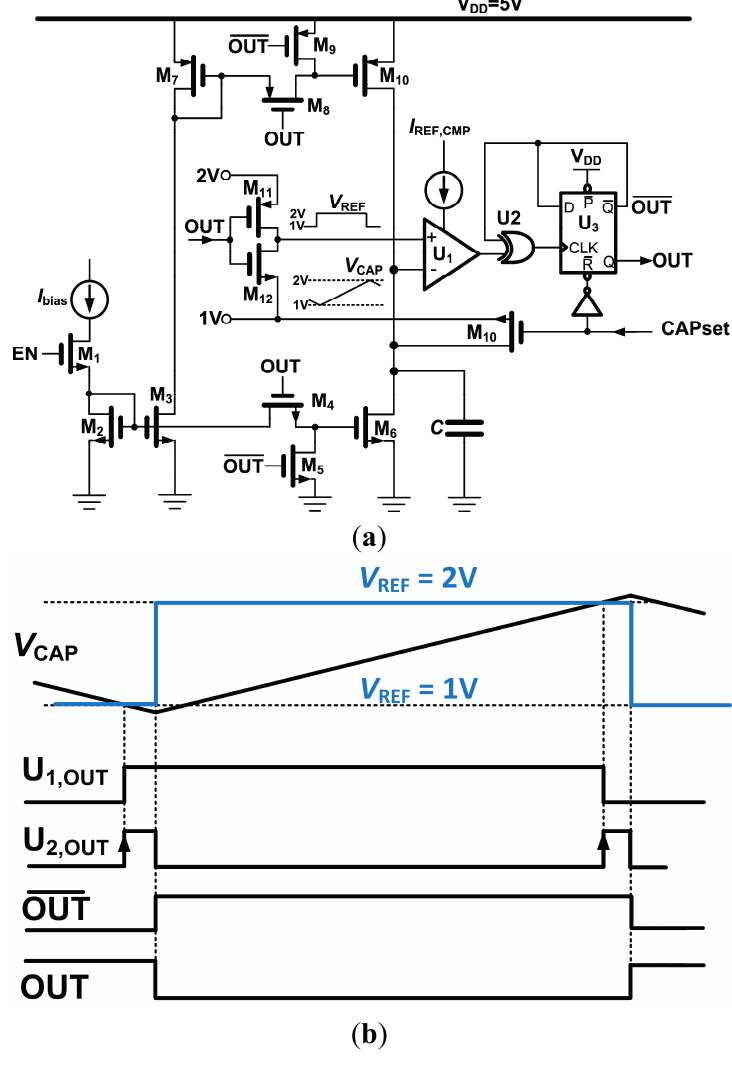
Figure 6. ( a ) Relaxation oscillator with a single comparator; ( b ) oscillator timing diagram (dimensions are not to